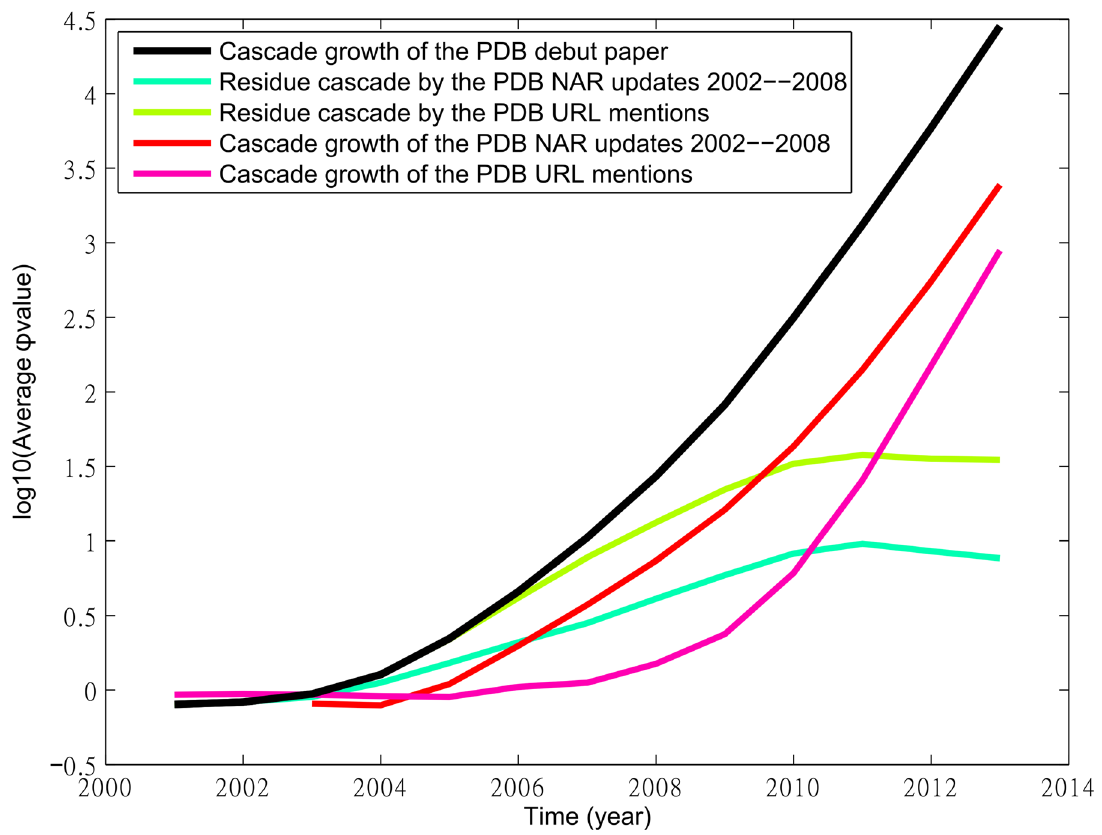
Fig 6. Growth of the cascade of the debut PDB article (black curve), the collection of PDB NAR update articles from 2002 to 2008, the PDB URL mentions articles, and their corresponding residue cascades. Notice the split between the black curve and green curve, indicating the cascade